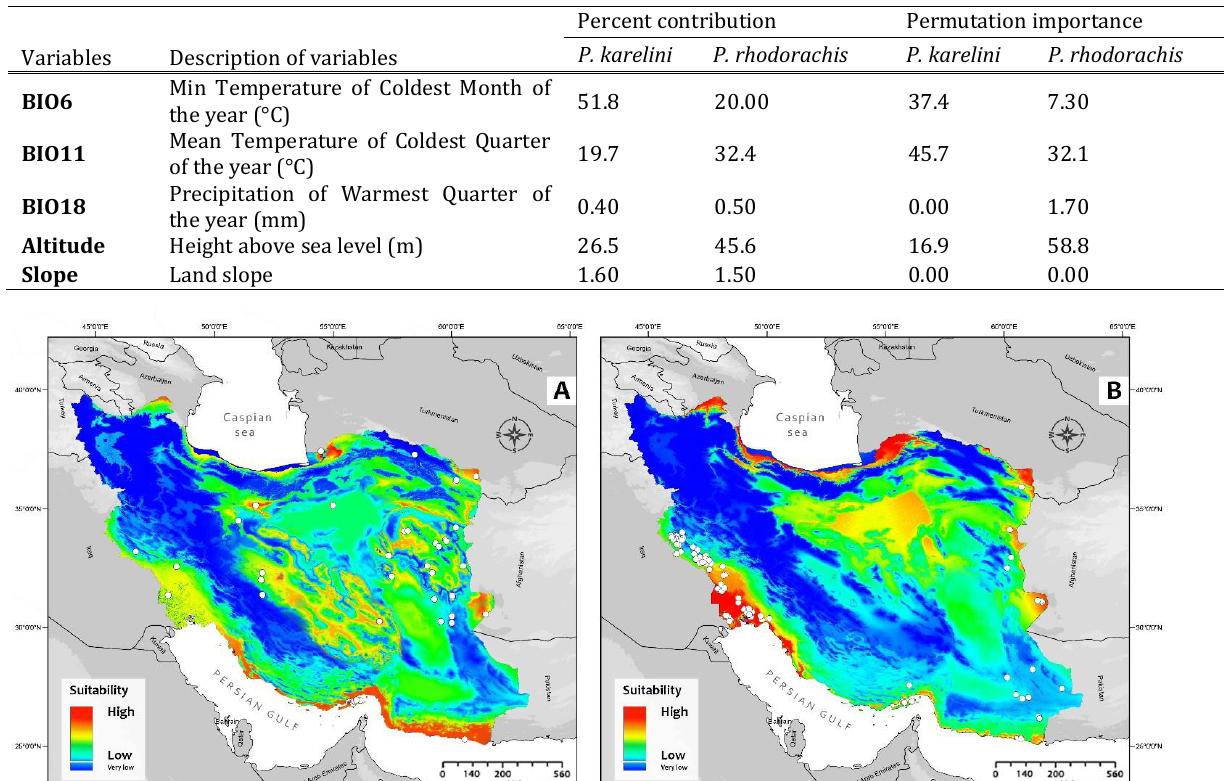
F IGURE 1. Predicted potential distributions of P. karelini (A) and P. rhodorachis (B) using MaxEnt, Habitat suitability is shown on the map using a gradient and the white circles indicate specimens collecting sites.